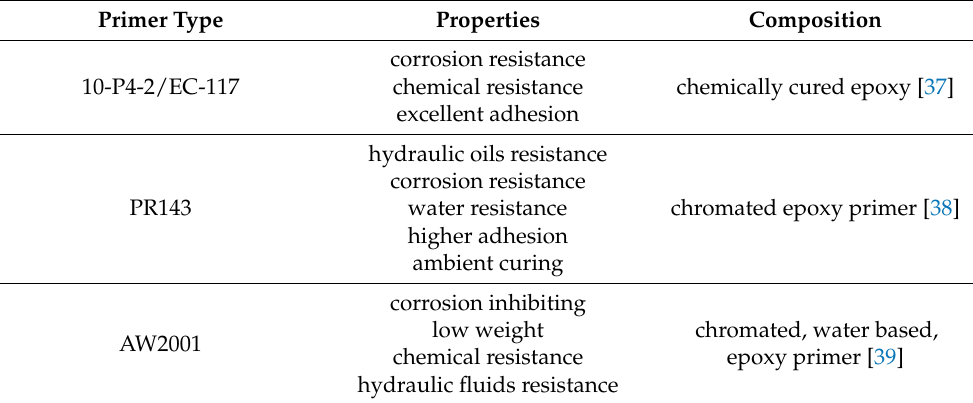
Table 1. Descriptions of